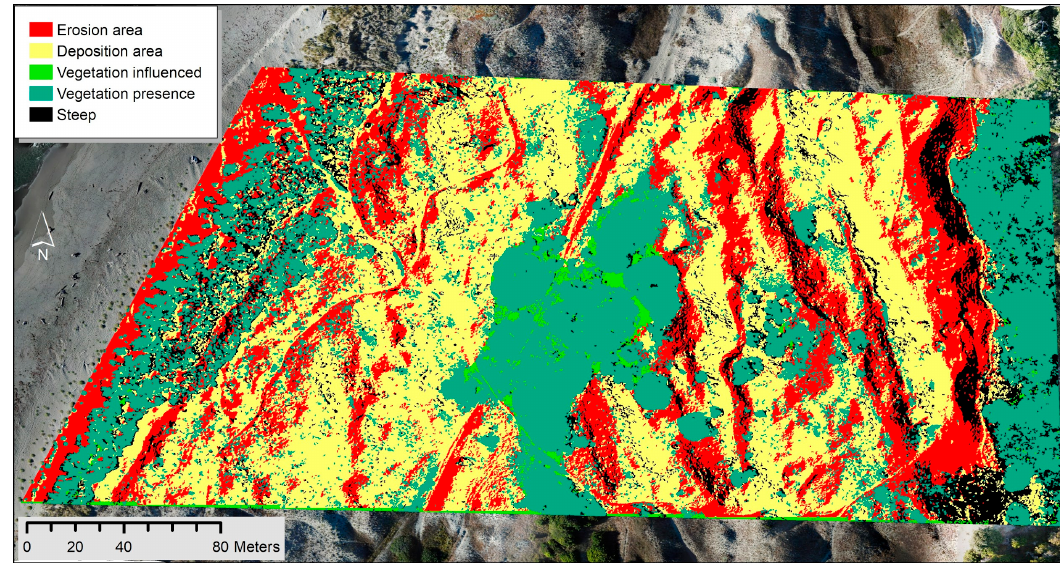
Figure 7. Map of results from the decision tree. Yellow shows the areas of potential gain of elevation, while the red shows areas of possible erosion.